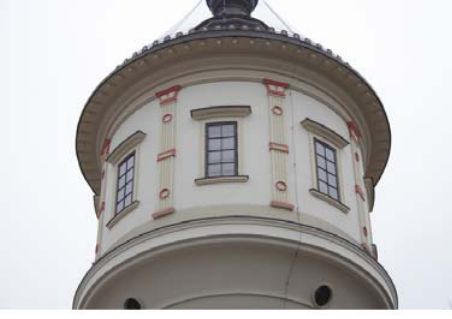
Figure 13. Detail of upper part